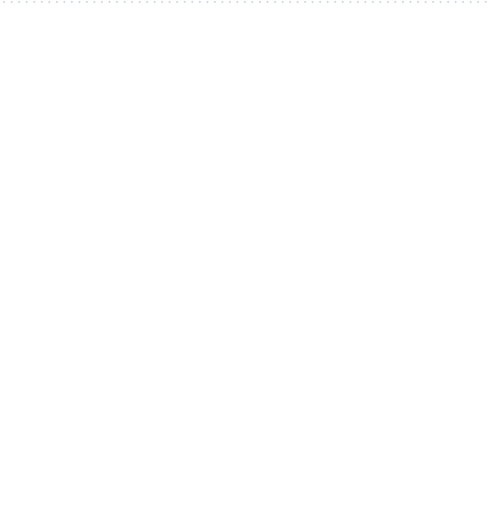
Figure 2. Calendar heatplot for Participant A (elevated anxiety and depression); each cell represents a daily TAS score.